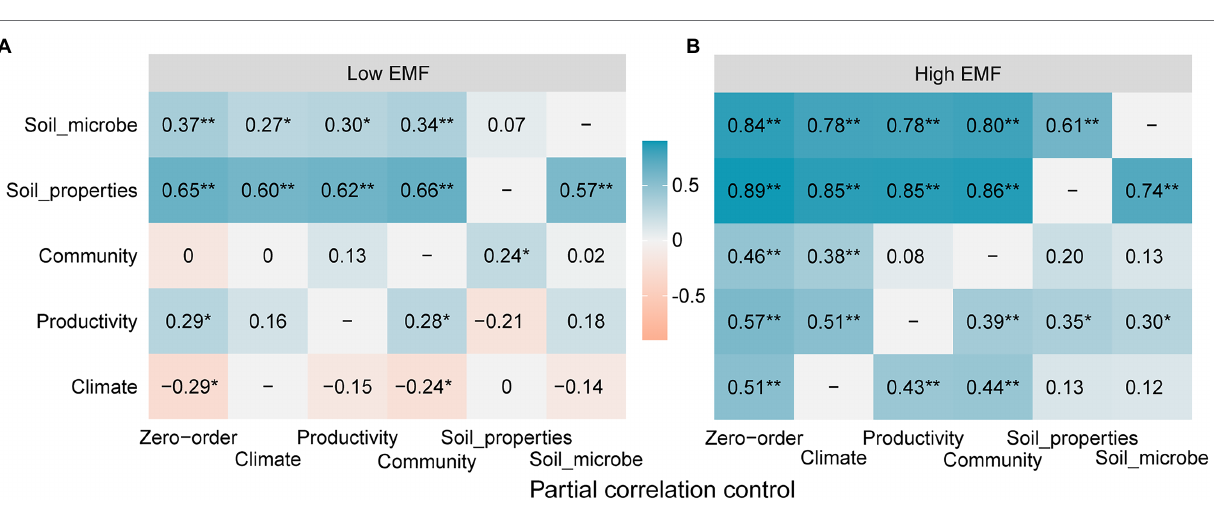
FIGURE 5 | Partial correlations among potential variables of climate, productivity, community functions, soil properties, soil microbial factors, and ecosystem multifunctionality (EMF) under (A) low EMF and (B) high EMF conditions, respectively. The value in the square represents the value of the correlation coefficient between potential variables from ordinate and ecosystem multifunctionality after eliminating the influence of abscissa variables. Zero-order represents the correlation coefficient between potential variables and EMF. * and ** show the significant correlations at 0.05 and 0.01